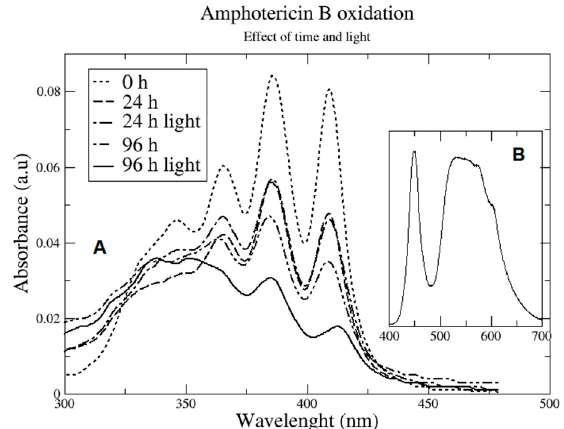
Figure 7. ( A )—Absorption spectra of Amphotericin B in PBS at pH 7.4 and exposed to air at ambient conditions as a function of time and illumination (2000 luxes). ( B )—Spectra of the LED lamp used for illumination.